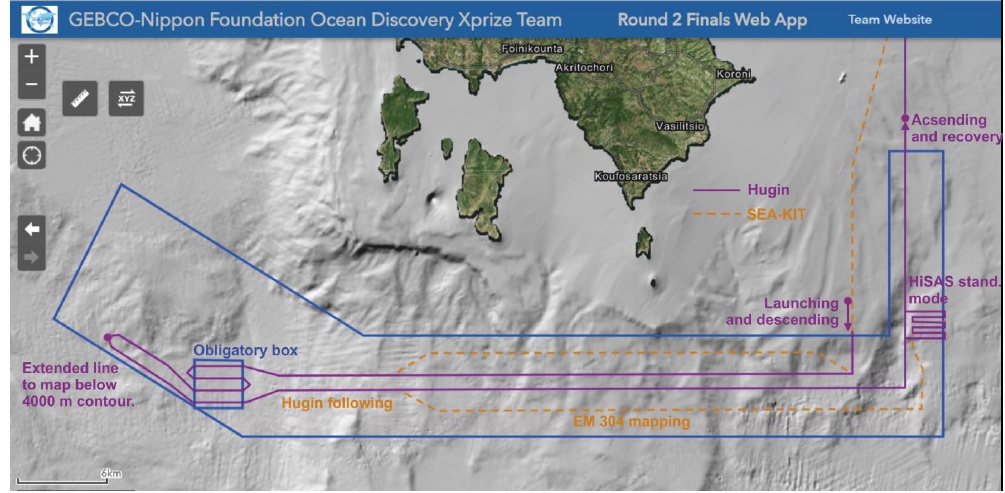
Figure 6. Planned survey lines for HUGIN AUV (purple solid) and SEA-KIT USV (orange dashed) including major elements of the